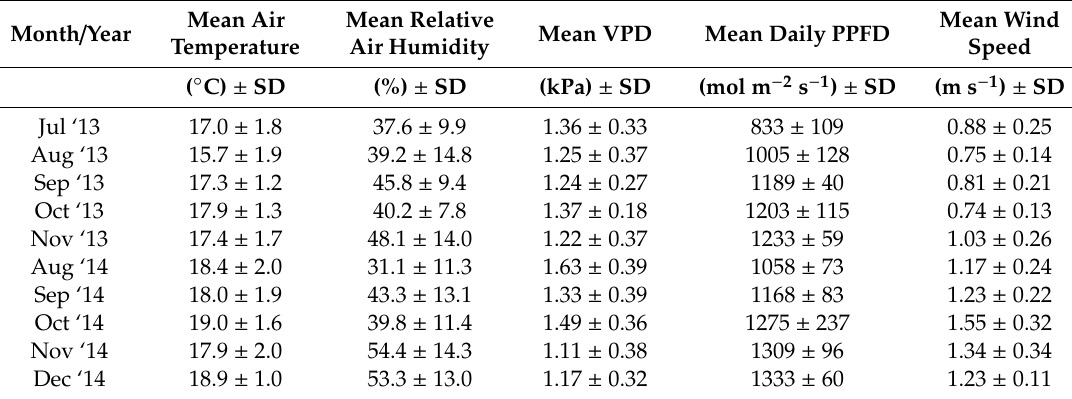
Table 1. Weather conditions during the experimental periods in 2013 and 2014 in St. Rita de Siguas, Arequipa, Peru. Data are shown as monthly averages of daily mean values. VPD: Vapor pressure deficit; PPFD: Photosynthetic photon flux density; SD: Standard deviation.